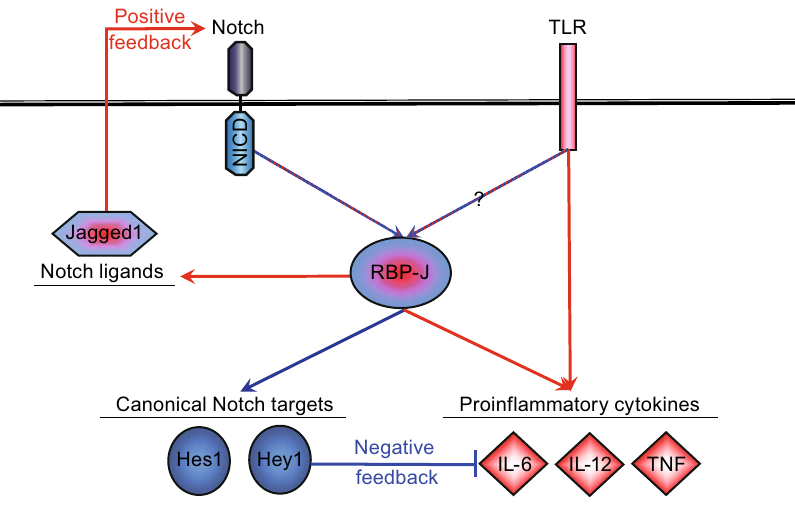
Figure 3. Crosstalk between the TLR signaling pathway and the Notch pathway. Expression and/or function of various components of the Notch pathways could be regulated by TLR signaling. Conversely, Notch pathway components positively or negatively modulate TLR-activated transcriptional, translational, and metabolic programs to fi netune outcomes of immune